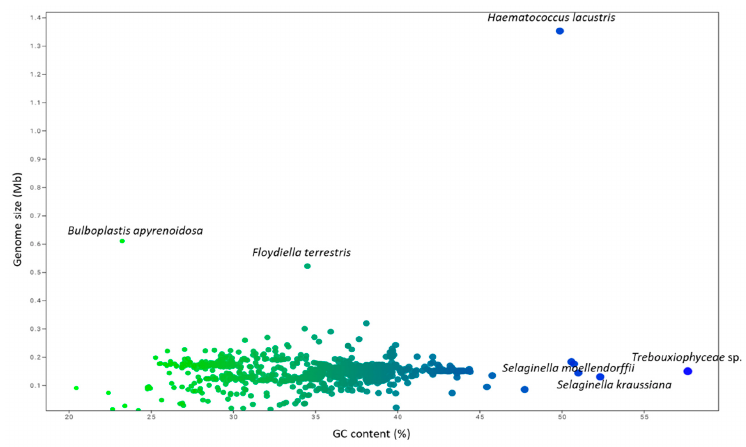
Figure 4. Genome size and GC (%) content in the chloroplast genome. The genome size of Haematococcus lacustris was highest (1.352 Mb) present in the upper right side (blue dot). The blue dot present at the right side of the figure represents the GC content of Trebouxiophyceae sp. MX-AZ01 that contain 57.66% GC nucleotides; however, the green dot present at the left upper part of the figure represents the lower GC content (23.25%) of Bulboplastis apyrenoidosa